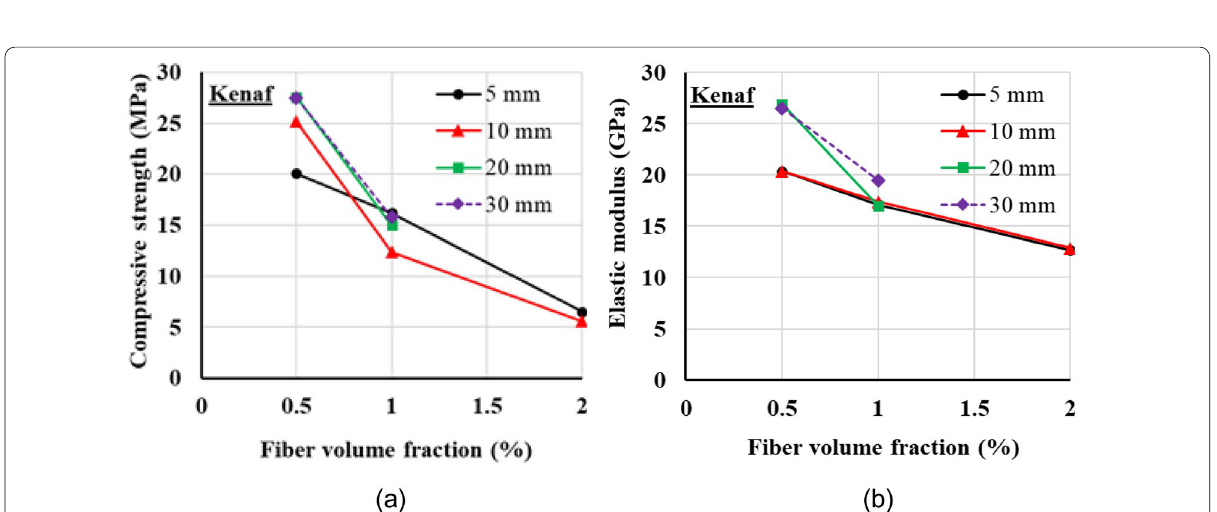
Fig. 15 Effect of kenaf fibers on a compressive strength and b elastic